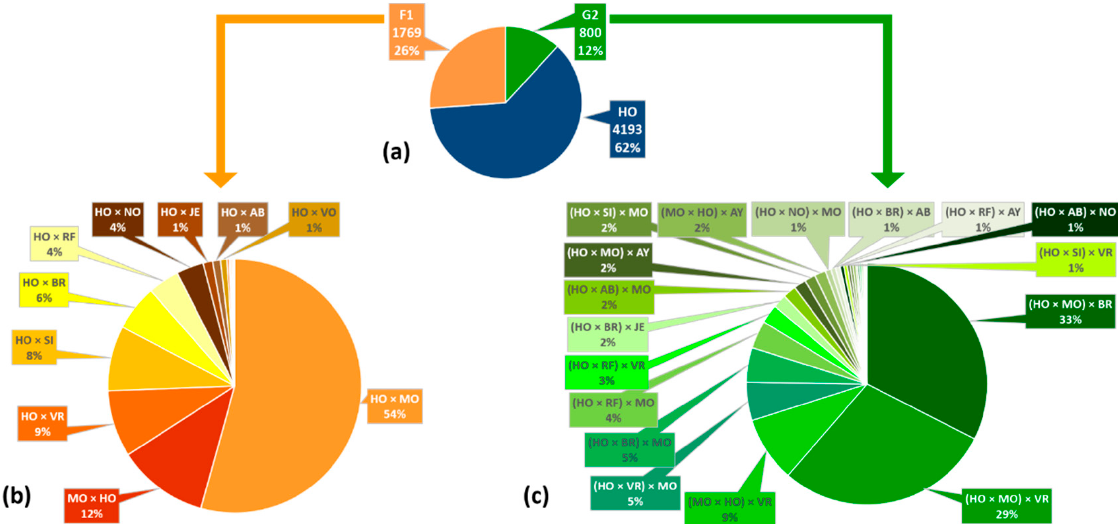
Figure 1. Different breed combinations for lactations data in dataset 1. ( a ) Number of lactations from the three genetic classes, i.e., HO, F 1 and G 2 . ( b ) Breed combinations for lactations in dataset 1 from first-generation crosses (n = 1769). ( c ) Breed combinations for lactations in dataset 1 from second-generation crosses (n = 800). HO = purebred Holstein; F1 = first-generation crosses (50% HO); G2 = second-generation crosses (25% HO). AB = Abondance; AY = Ayrshire; BR = Brown Swiss; JE = Jersey; MO = Montbéliarde; NO = Normande; RF = Belgian Red; SI = Simmental; VO = Vosgienne; VR = Viking Red.